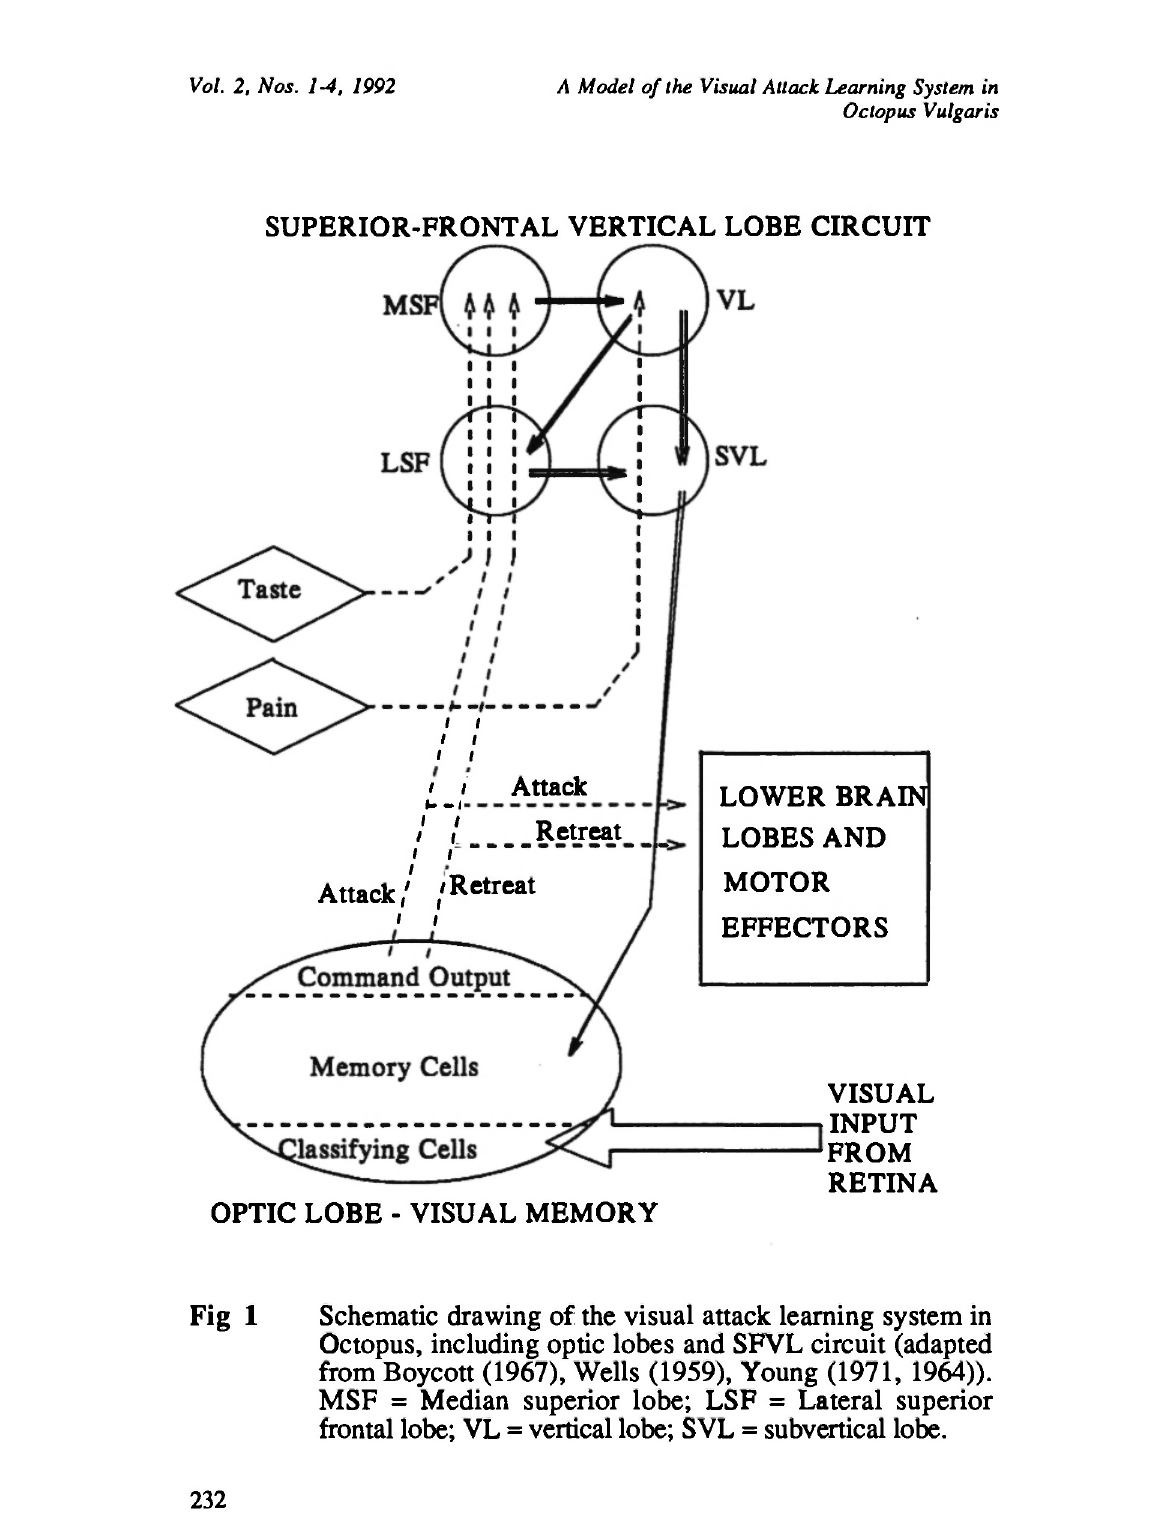
Schematic drawing of the visual attack learning system in Octopus, including optic lobes and SFVL circuit (adapted from Boycott (1967), Wells (1959), Young (1971, 1964)). MSF = Median superior lobe; LSF = Lateral superior frontal lobe; VL = vertical lobe; SVL = subvertical